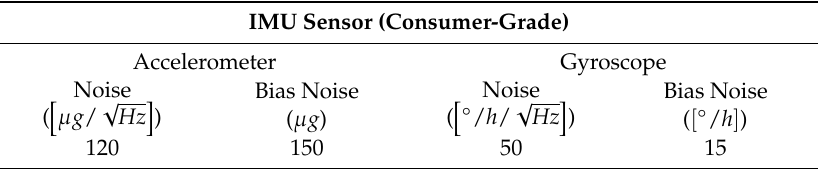
Table 1. IMU noise simulation parameters.